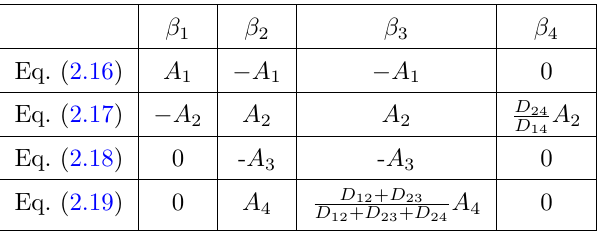
Table 3 . Value of β α in (A.4) in order to reproduce the four